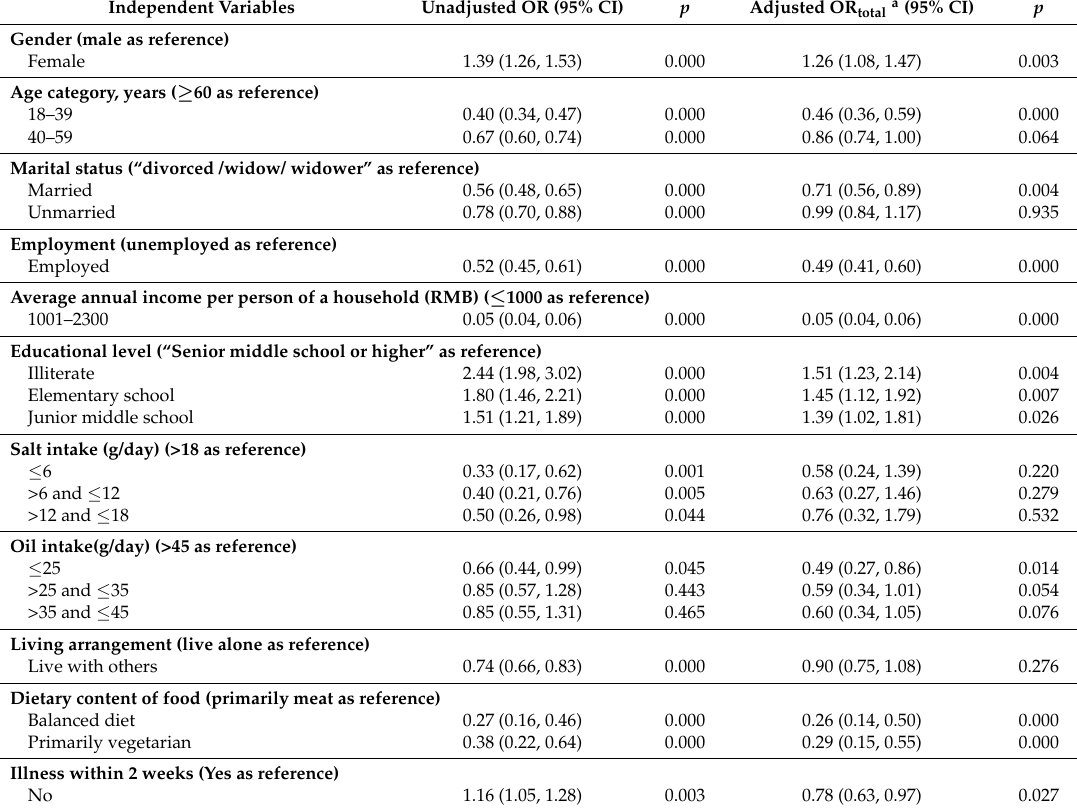
Table 4. Multivariable logistic regression of factors associated with poor sleep